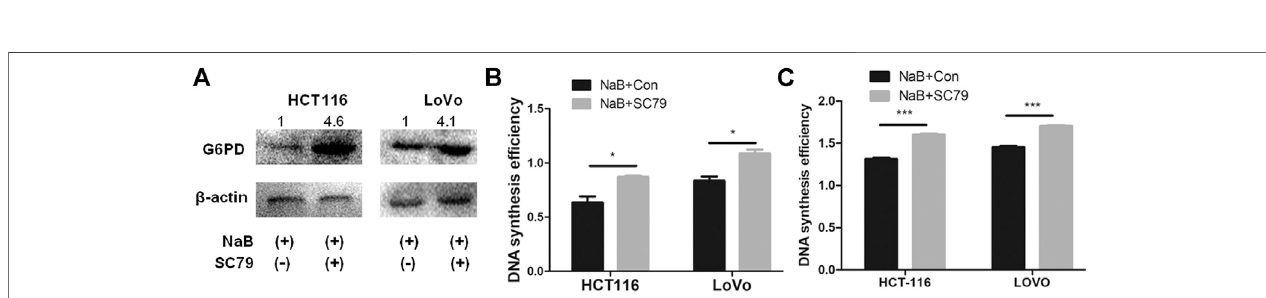
FIGURE 4 | Butyrate regulated G6PD abundance and DNA synthesis of colon cancer cells through the AKT pathway. (A ) The protein levels of G6PD were measured by western blotting in HCT116 and LoVo cells being treated with 2 mM butyrate alone or co-incubated with 2 mM butyrate and 10.96 μ M SC79 for 24 h. (B) Theeffectsof10.96 μ MSC79(markedas “ NaB+SC79 ” )orPBSvehicle(labeledas “ NaB+Con ” )oncellproliferationweretestedbyCCK-8assayinHCT116andLoVo cells which were incubated with 2 mM butyrate for 24 h. (C) After being treated with a combination of 2 mM butyrate and PBS vehicle (labeled as “ NaB + Con ” ) or 2 mM butyrate and 10.96 μ M SC79 (marked as “ NaB + SC79 ” ) for 24 h, the DNA synthesis ef fi ciency in HCT116 and LoVo cells was assayed by BrdU incorporation experiment. The error bars showed standard deviations from independent triplicates. * p < 0.05, *** p < 0.001.